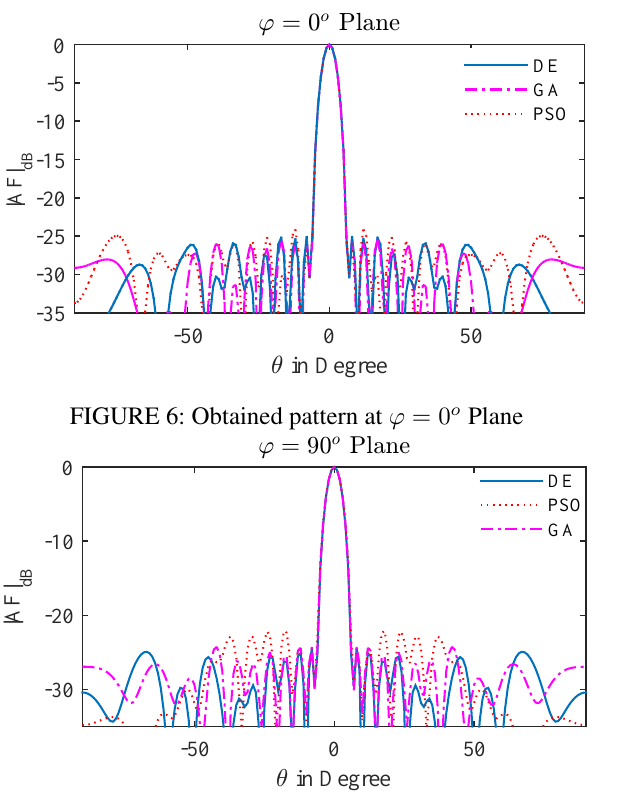
FIGURE 7: Obtained pattern at ϕ = 90 o Plane